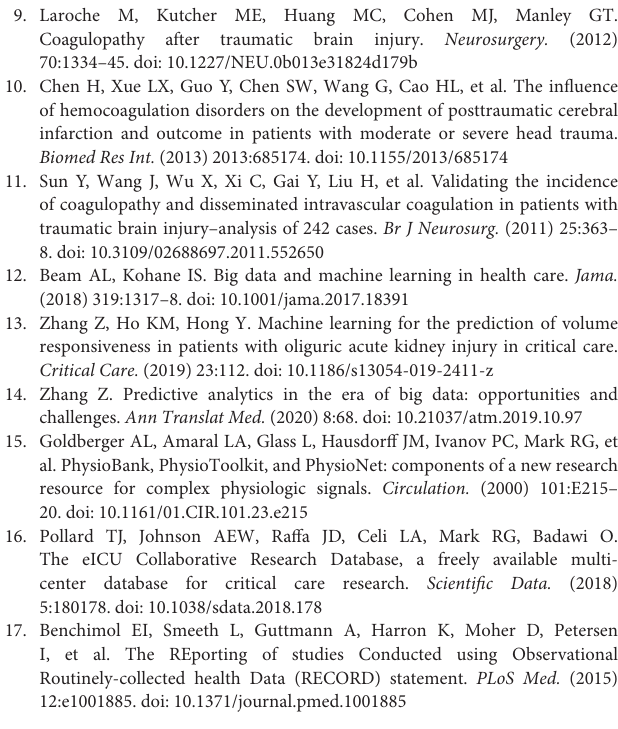
Supplementary Table 1 | Missing number (%) for included variables in the dataset. Supplementary Table 2 | Baseline characteristics of the eICU-CRD